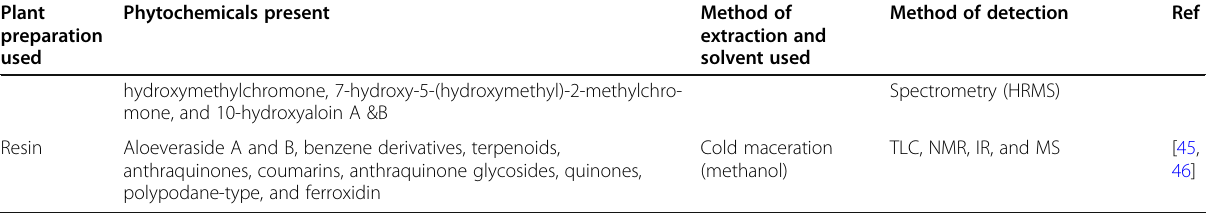
Table 2 Phytochemical profile of the gel, skin, powder, and extracts from A. vera leaves (Continued) Plant preparation